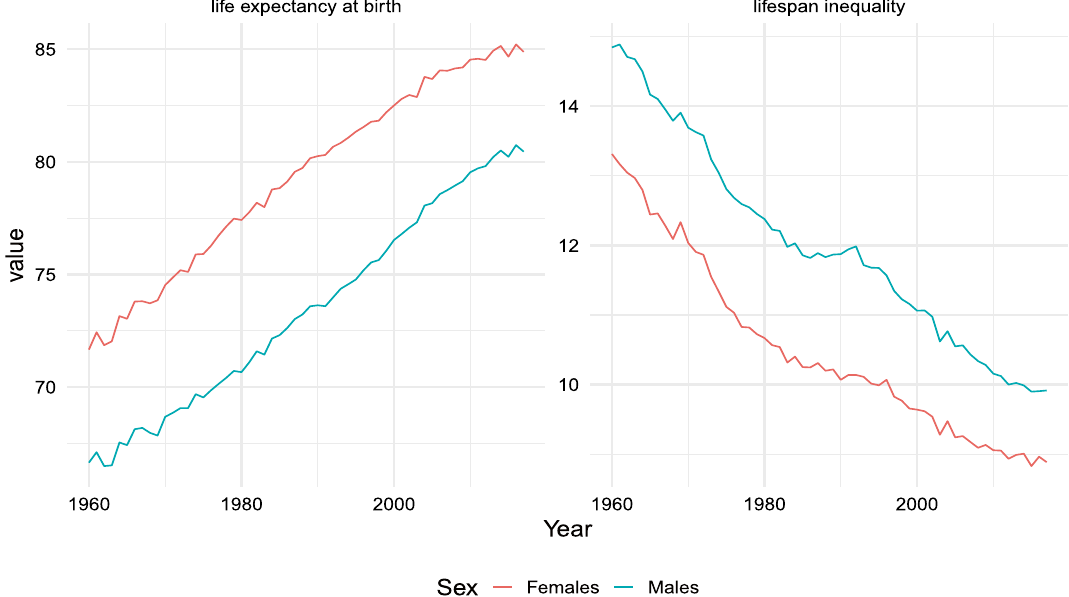
Figure 1. Lifespan inequality and life expectancy trends from 1960 to 2015 by sex. Source : authors’ own elaborations on data from the HMD 5